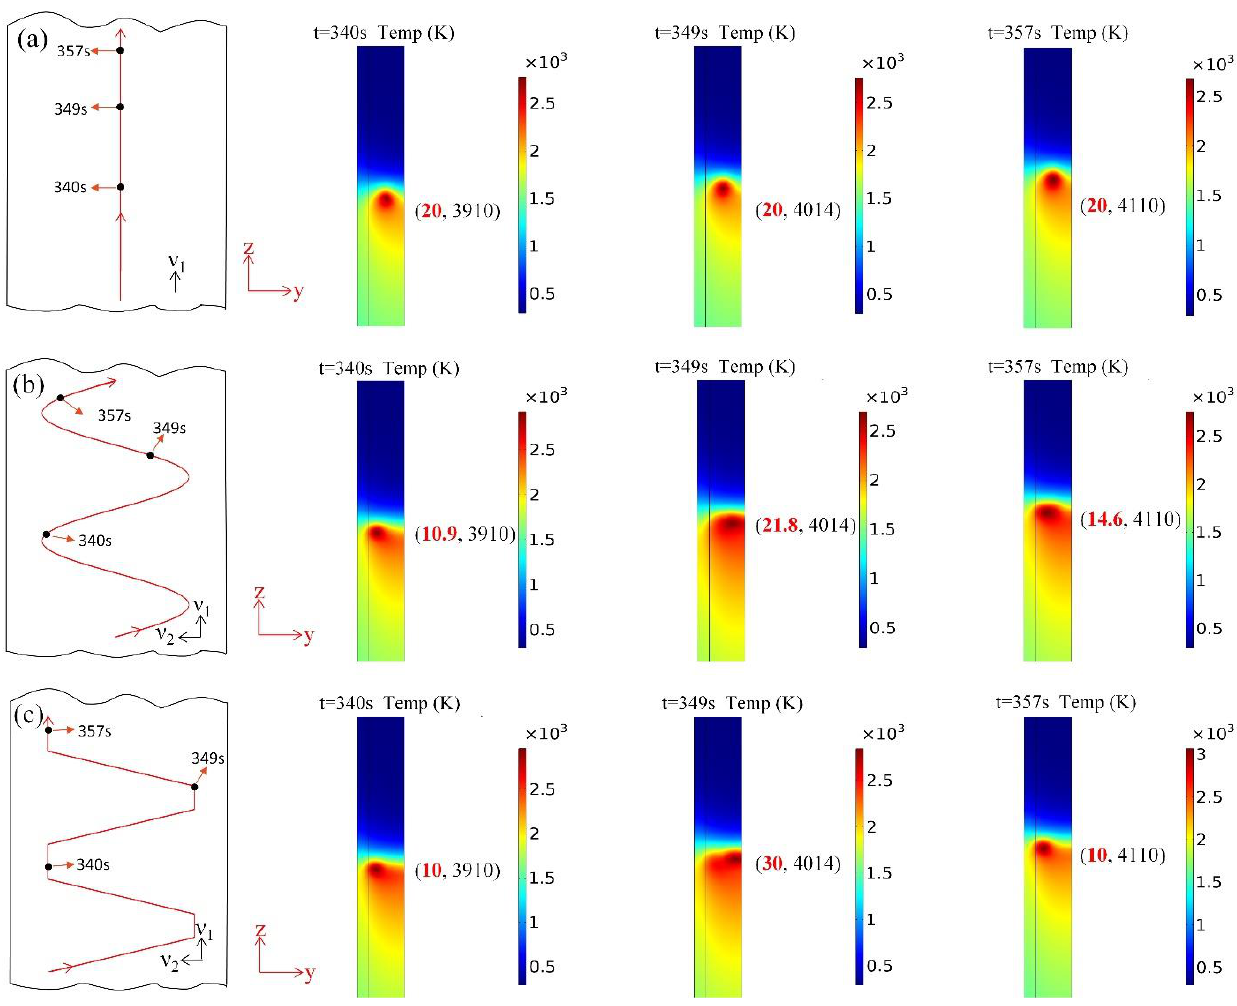
Figure 10. Calculated thermal profiles using three different heat source paths at different welding times of 340 s, 349 s and 357 s. ( a ) linear path ( b ) sinusoidal path, ( c ) oscillate-stop